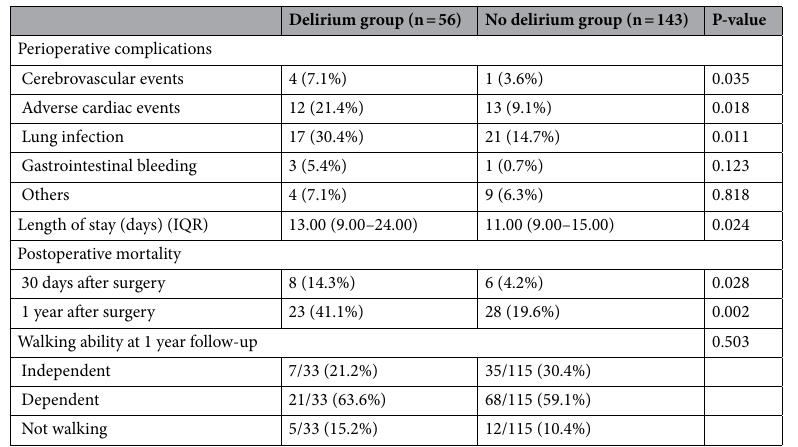
Table 4. Comparison of the outcome of patients with or without delirium in nonagenarians with hip fracture. IQR interquartile